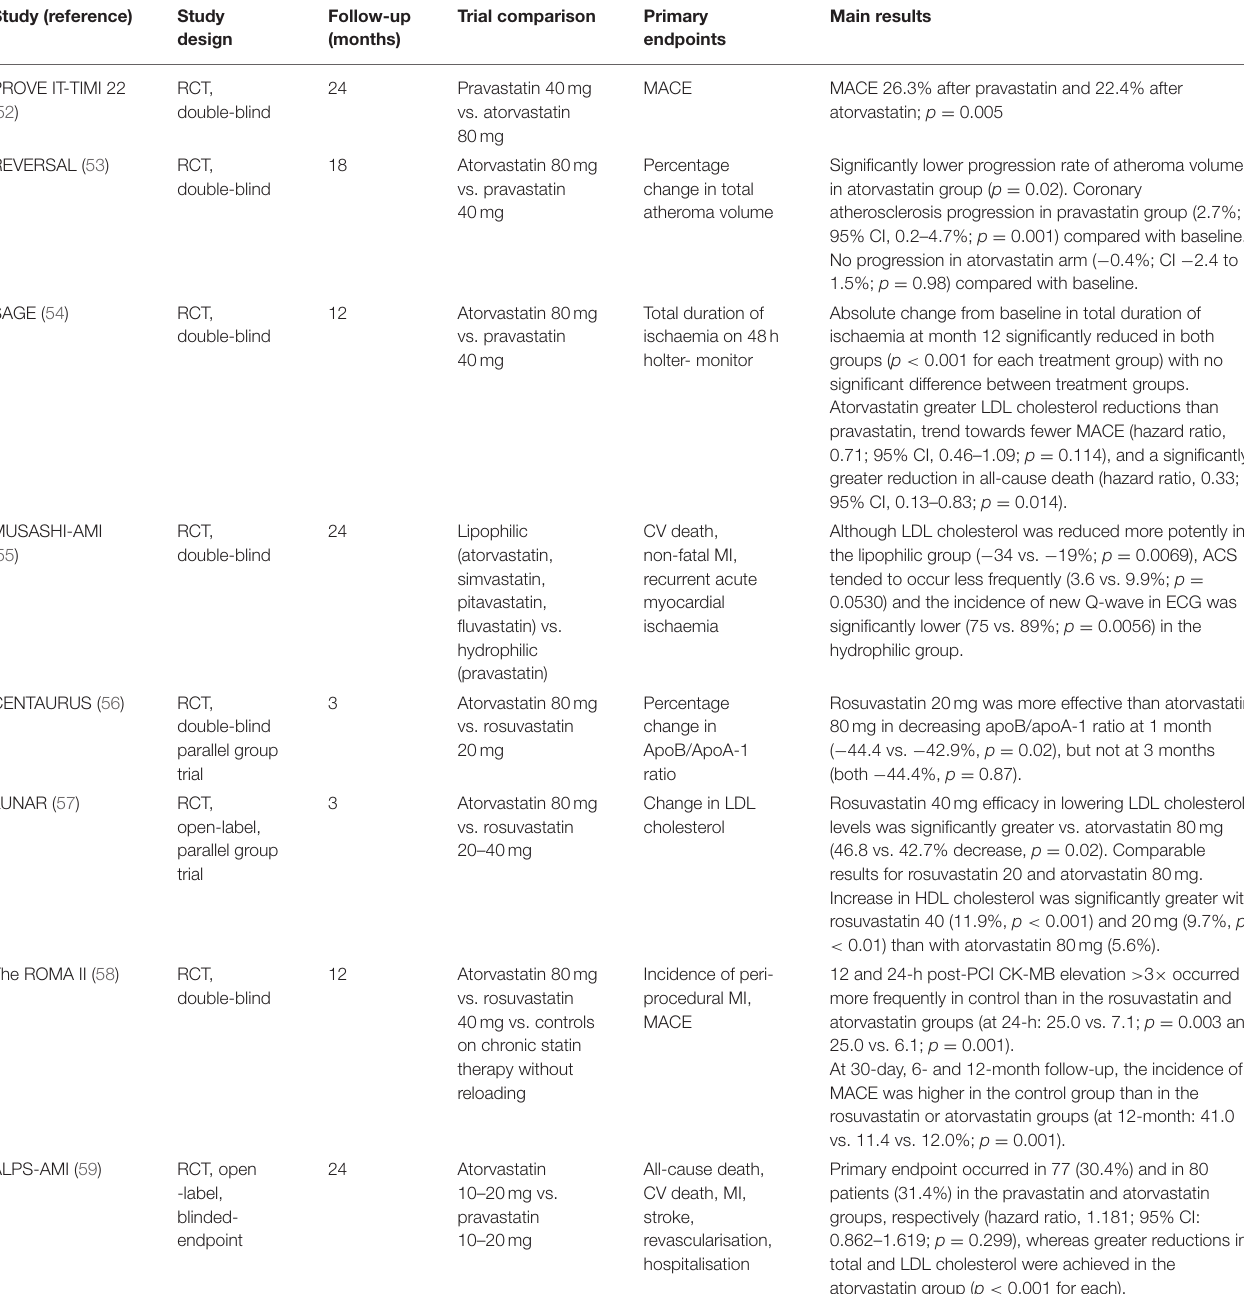
TABLE 2 | Trials comparing hydrophilic and lipophilic statins and coronary artery